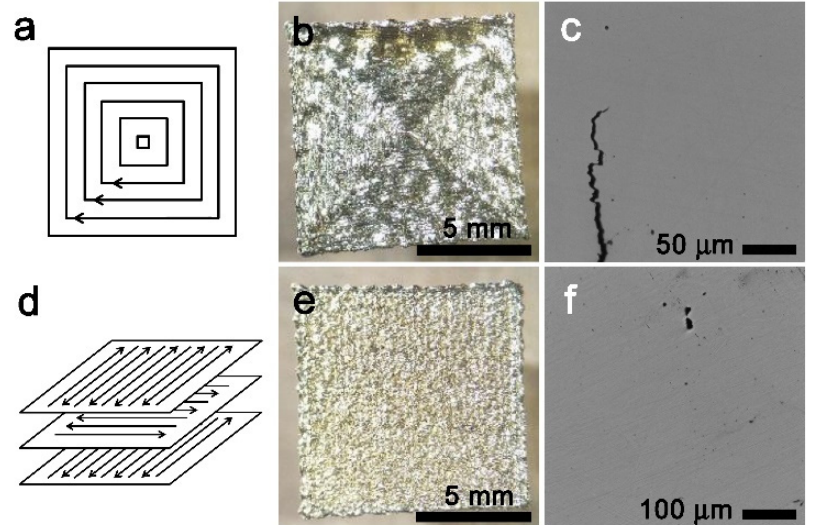
Figure 5. Scanning patterning strategies: ( a ) total fill scanning pattern (TF) and ( d ) meander scan- ning pattern (M). These methods give the pieces a final appearance shown in ( b , e ), respectively. ( c , f ) Optical micrographs of the corresponding